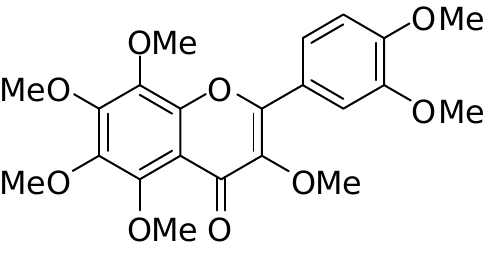
Figure 1. Structure of 3,5,6,7,8,3 ′ ,4 ′ -heptamethoxyflavone